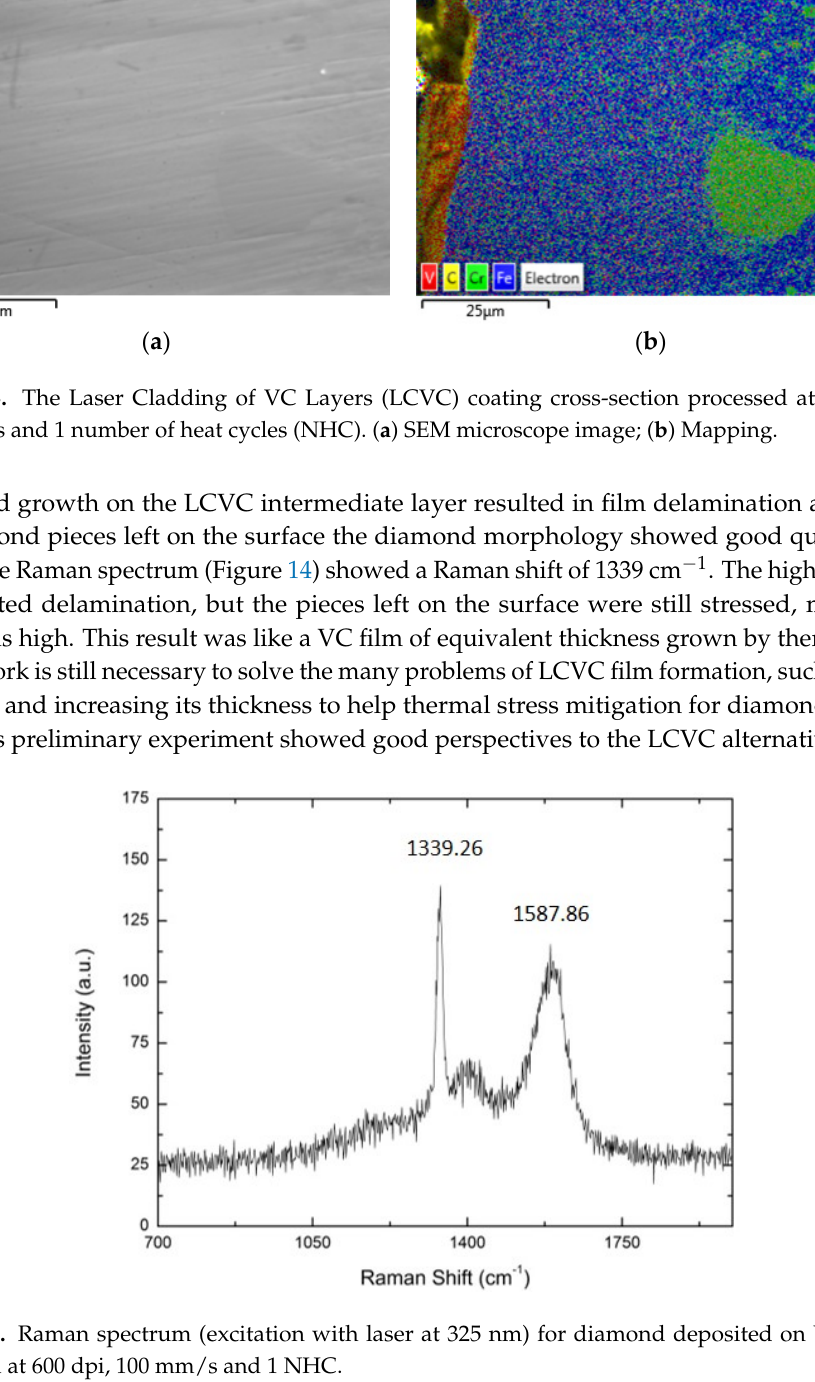
Figure 14. Raman spectrum (excitation with laser at 325 nm) for diamond deposited on VC layer processed at 600 dpi, 100 mm/s and 1 NHC.